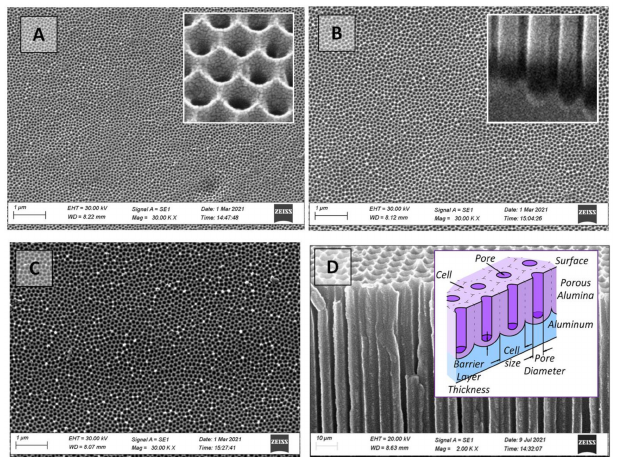
Figure 2. SEM images of the top view (outer surface) of as-fabricated PAA membranes with a size of 15 mm × 15 mm: ( A )—40 V, ( B )—50 V, ( C )—60 V, ( D )—PAA cross-section. The insets show enlarged images of the surface ( A ) and the bottom part of the PAA cross-section ( B ); and a schematic cross-section view of the PAA ( D